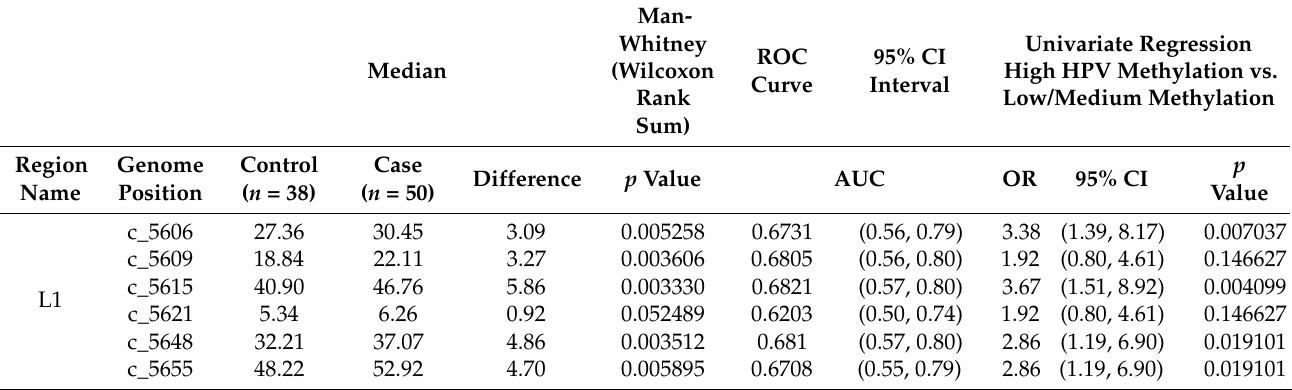
Table 2. Median methylation values of cases and controls by next-generation